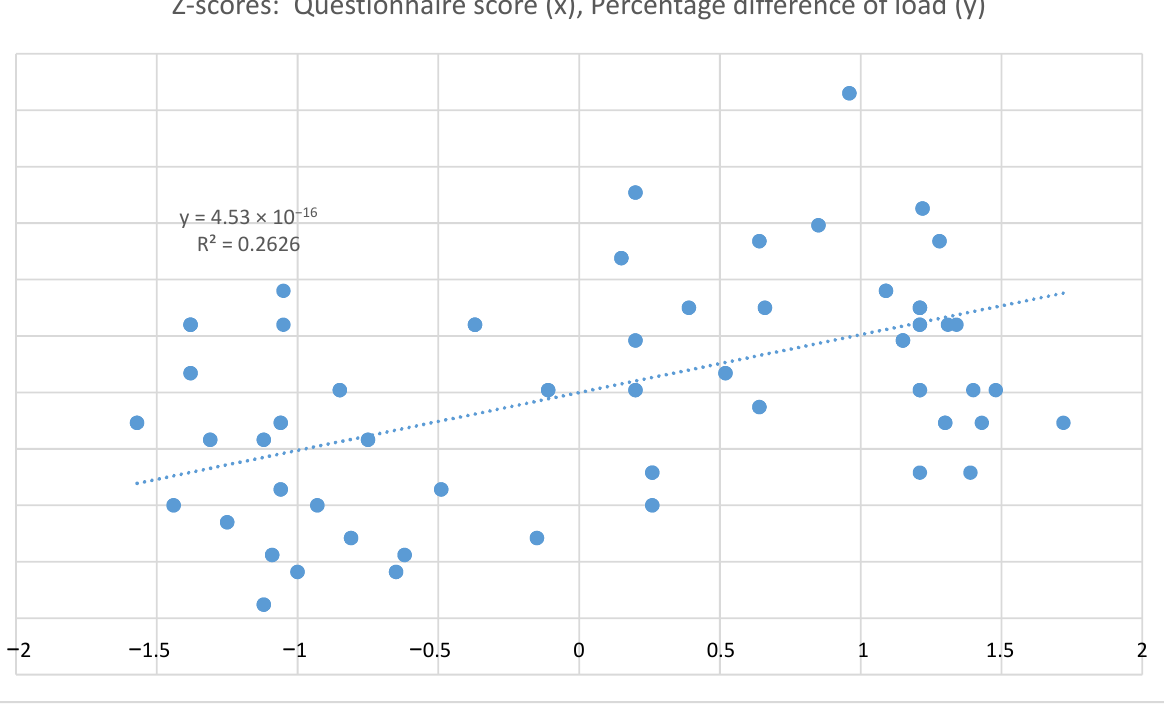
Figure 1. Scatter plot graphic (with linear interpolation and regression equation).